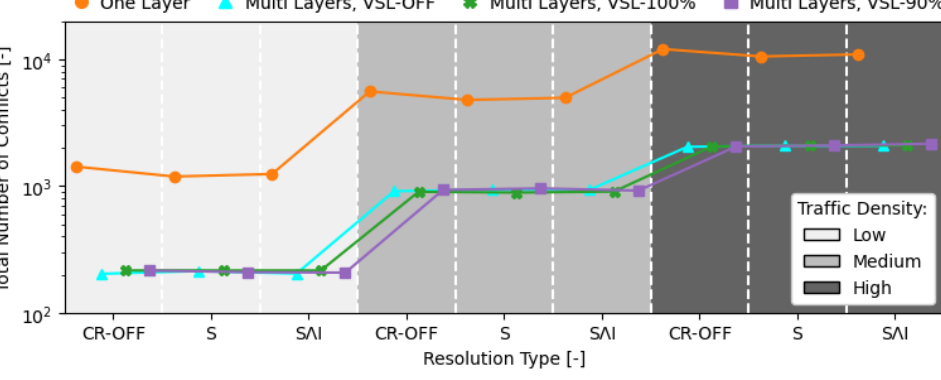
Figure 17. Mean total number of pairwise conflicts.